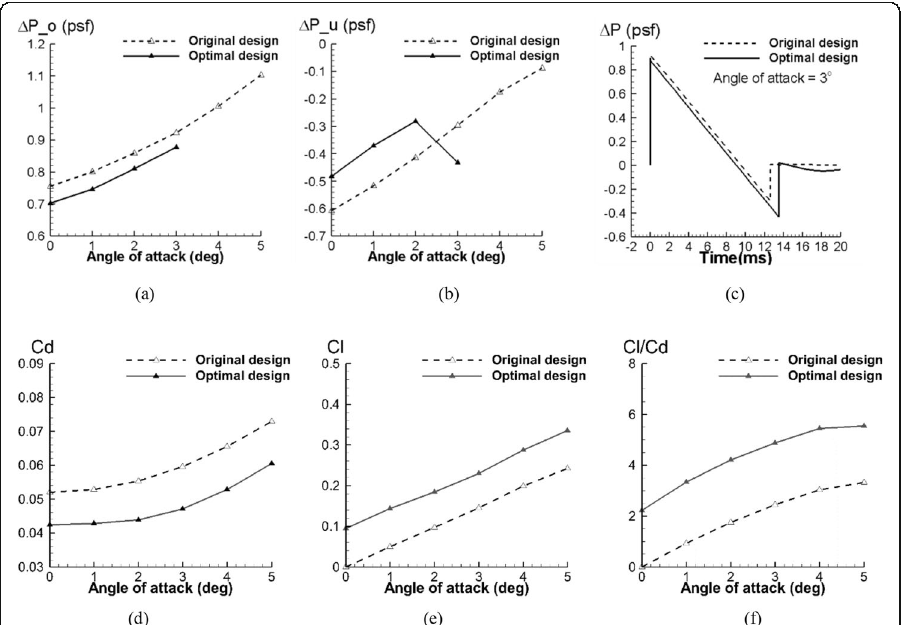
Fig. 19 The ground boom signatures and drag coefficients for the baseline and optimized NACA0008 airfoil with different angles of attack. a the maximum overpressure vs the angle of attack; b the maximum underpressure vs the angle of attack; c comparison of the ground boom signature at the angle of attack = 3 o ; d the drag coefficient vs the angle of attack; e the lift coefficient vs the angle of attack; f the lift-drag ratio vs the angle of